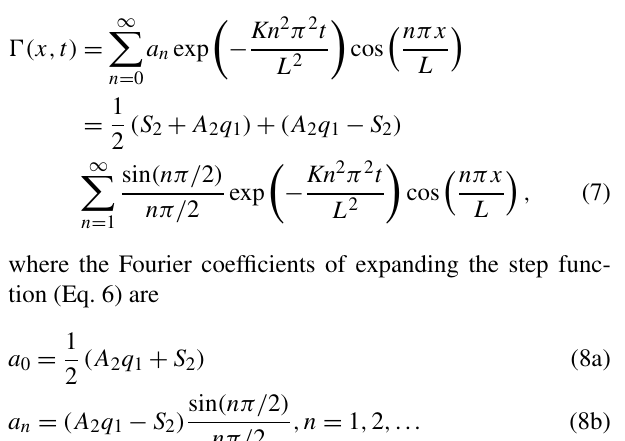
Eq. (5) with initial conditions (Eq. 6) is (Polyanin and Zait- sev,